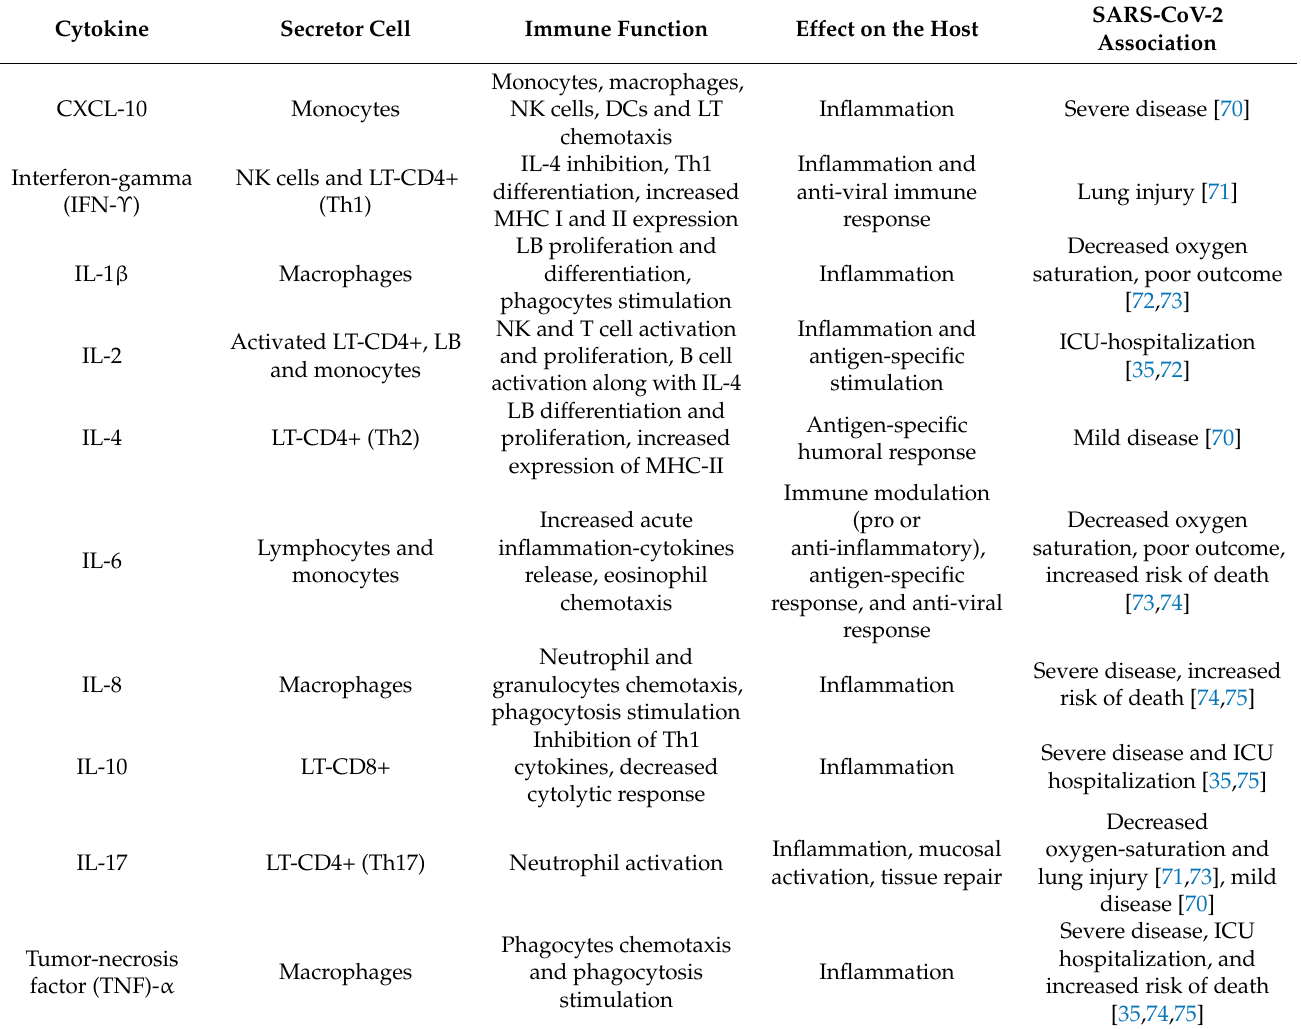
Table 1. Cytokines studied in SARS-CoV-2 immune response, the cell responsible for its secre- tion, immune function of the cytokine, effects modulated in the host and relations established in COVID-19